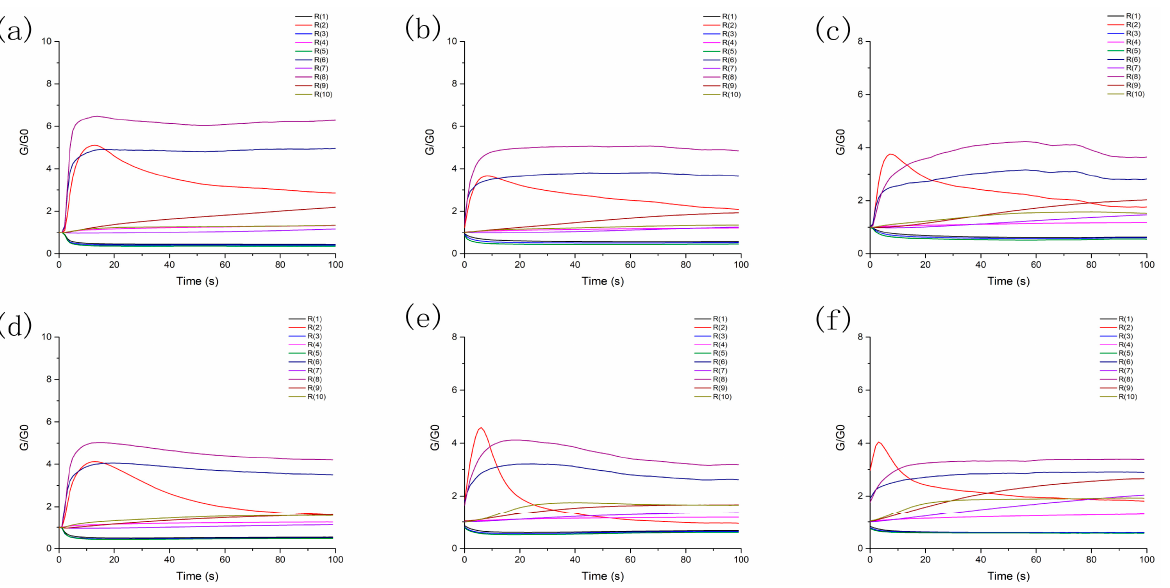
Figure 3. E-nose patterns: ( a ) ten sensors’ response to volatile components from HO of the CLs, ( b ) ten sensors’ response to volatile components from EHS of the CLs, ( c ) ten sensors’ response to volatile components from MRS of the CLs. ( d ) ten sensors’ response to volatile components from HO of the CBs, ( e ) ten sensors’ response to volatile components from EHS of the CBs, and ( f ) ten sensors’ response to volatile components from MRS of the CBs.